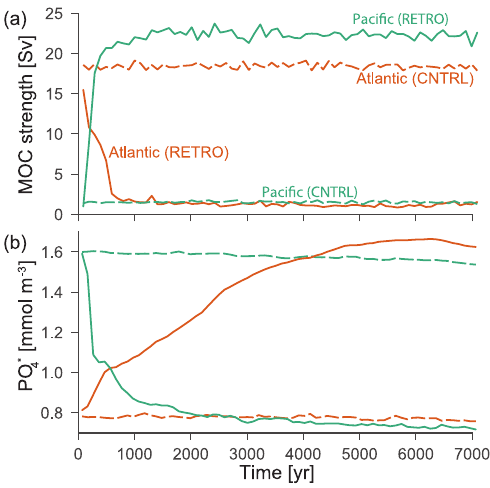
Figure 1. Time series (100-year means) of meridional overturn- ing circulation for the Atlantic (orange) and Pacific (turquoise) at 30 ◦ N (a) ; a water mass tracer (PO ∗ ) at two locations in the north- 4 ern Atlantic (mean of 28–38 ◦ N, 60–70 ◦ W) and northern Pacific (mean of 28–38 ◦ N, 150–160 ◦ W) (b) . RETRO is shown by the solid lines and CNTRL by the dashed lines in both panels. PO ∗ 4 (PO 4 + O 2 / 172 − 1 . 5) combines concentrations of phosphate and oxygen in such a way that, to first order, biological impacts are eliminated and thus can be used as a (quasi-)conservative prop- erty, which in the prograde world is used to track the contributions of North Atlantic deep water (NADW) and Antarctic bottom wa- ter (AABW) to the ventilation of the deep Pacific and Indian Ocean (Rae and Broecker,